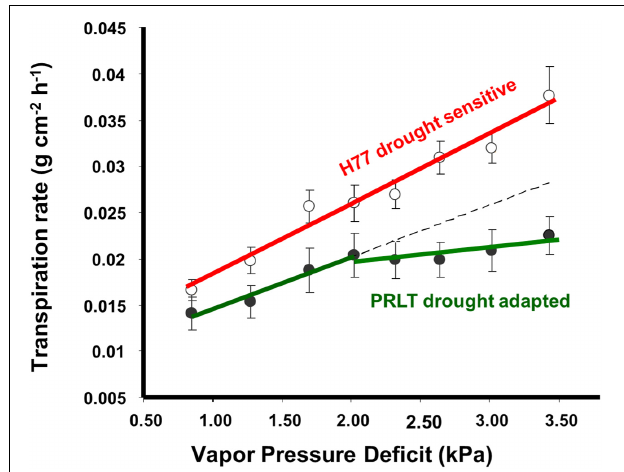
FIGURE 1 | Pearl millet genotypes contrasting for drought adaptation were shown to differ in their transpiration response to increase in vapor pressure deficit (VPD, adopted from Kholová et al., 2010b).